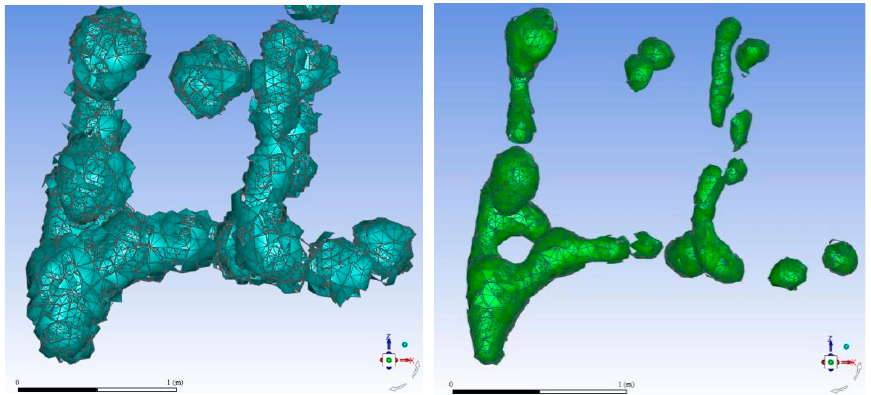
Figure 20. Contour surface of volume fraction near the ground and mesh cells in this region (the volume fraction was 0.01 in the left figure and 0.5 in the right figure).